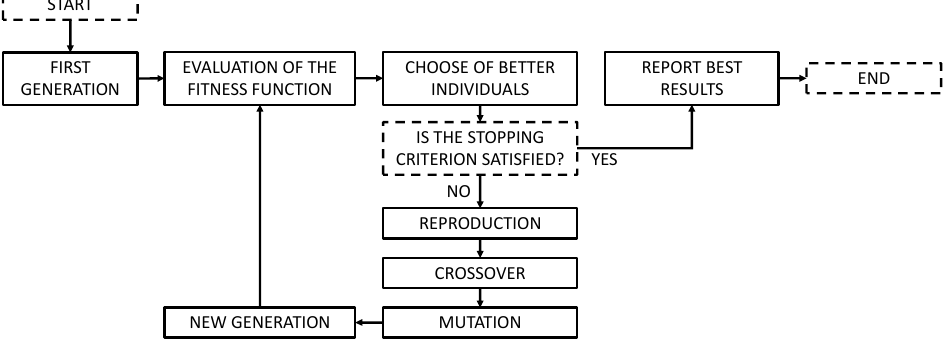
Figure 1. Classical GA scheme.